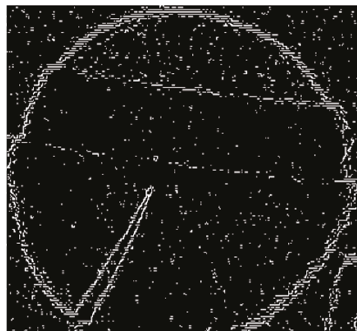
Figure 10: Image after edge detection using LoG operator.